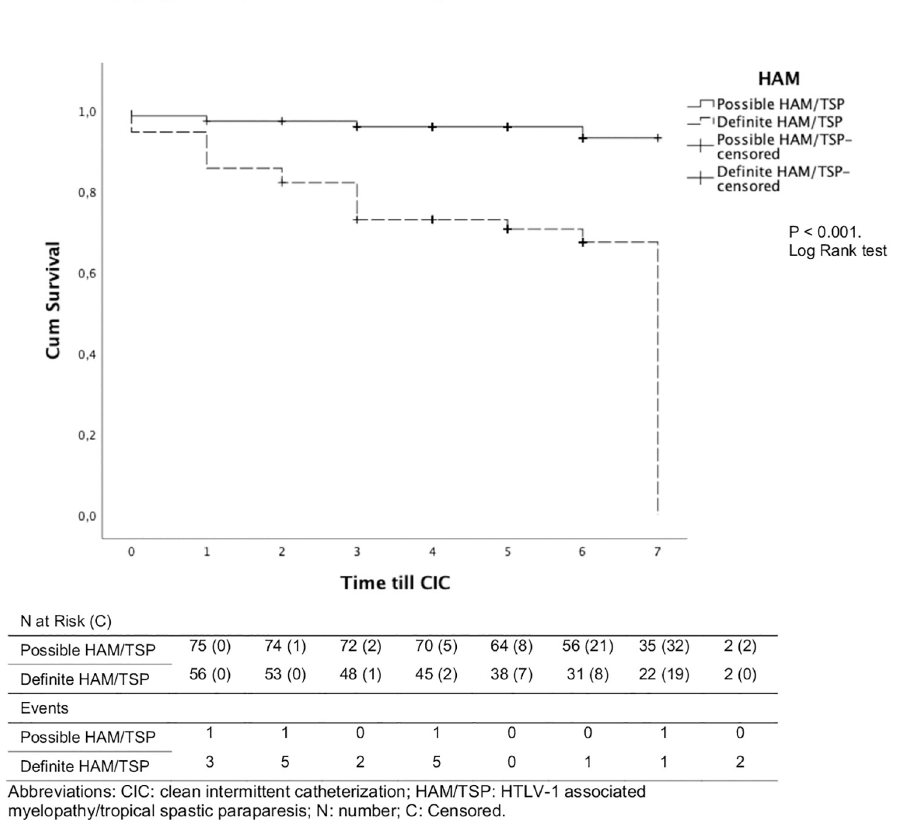
Fig 1. Kaplan-Meier Curves of Time to Clean Self-Intermittent Catheterization in Patients with Possible and Definite HAM/TSP. Time since cohort admission until need for clean self-intermittent catheterization (CIC) to promote bladder emptying in 131 patients free of CIC upon cohort